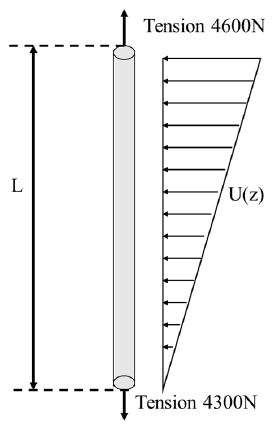
Figure 17. Riser of high-mode VIV model test [5]. Table 6. Parameters of tensioned riser model with shear current.